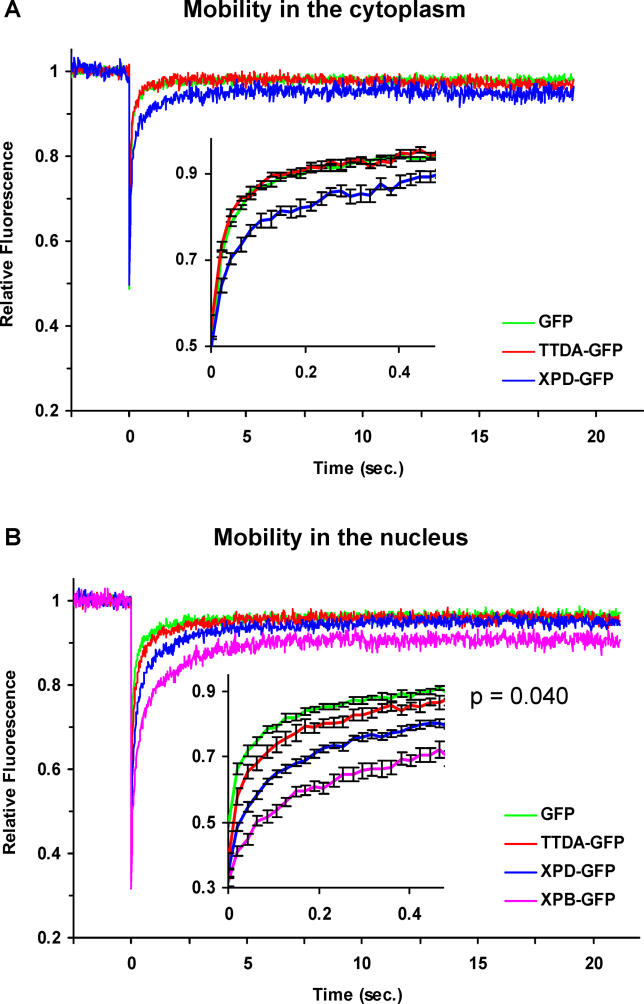
Mobility of TTDA-GFP and XPD-GFP in the Cytoplasm and in the Nucleus Determined by FRAP(A) FRAP analysis of XPD-GFP (blue line), TTDA-GFP (red line), and free GFP (green line) residing in the cytoplasm. Inset shows increased time resolution of the curves with error bars.(B) FRAP analysis of XPB-GFP (pink line), XPD-GFP (blue line), TTDA-GFP (red line), and free GFP (green line) in the nucleus. Relative fluorescence (fluorescence post-bleach divided by fluorescence pre-bleach) plotted against time in seconds. Inset shows increased time resolution of the curves with error bars. The
p-value has been calculated for GFP and TTDA-GFP datasets.